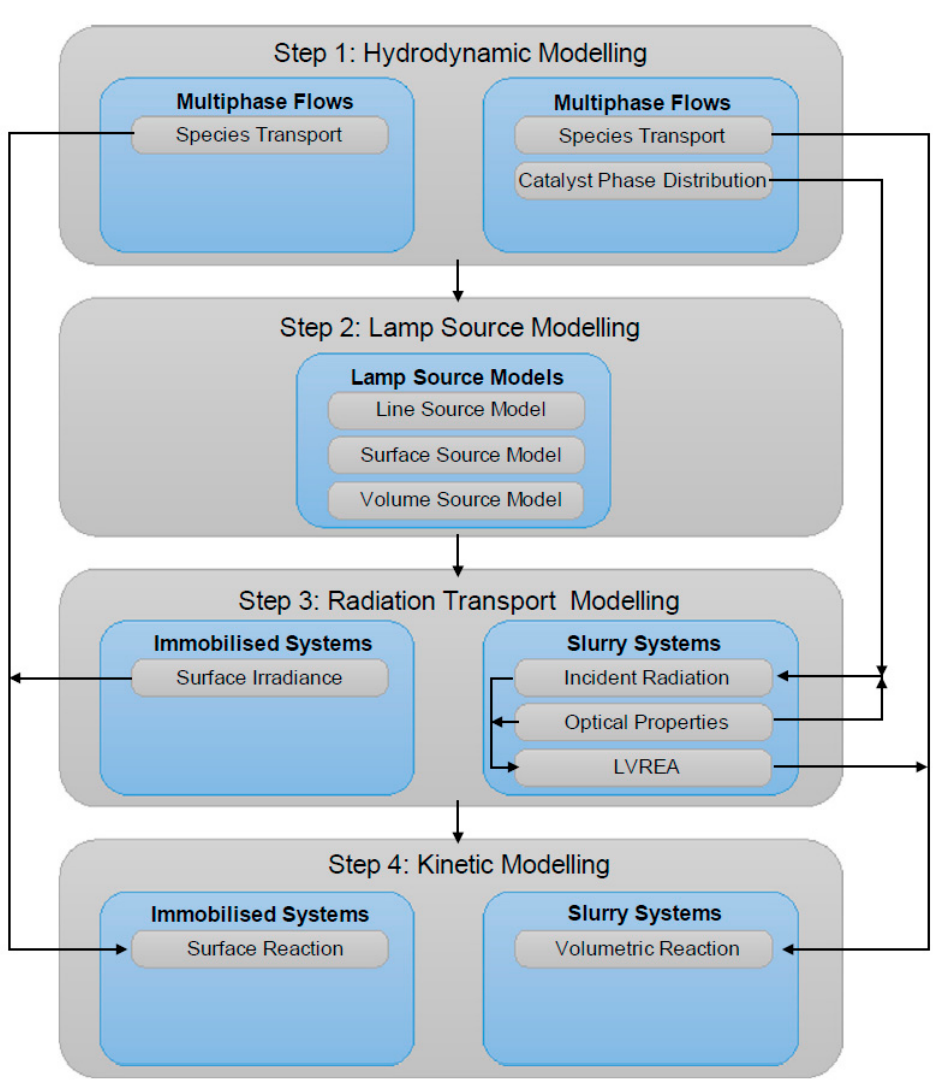
Figure 6. The sequential steps in the CFD modeling of photocatalytic reactors. Reprinted with permission from [72]. Copyright Elsevier, 2013.